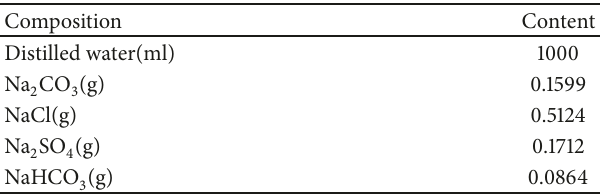
Table 1: Composition of soil simulated